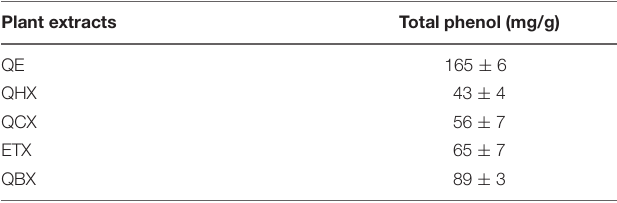
TABLE 3 | Total phenolic content of Q. incana